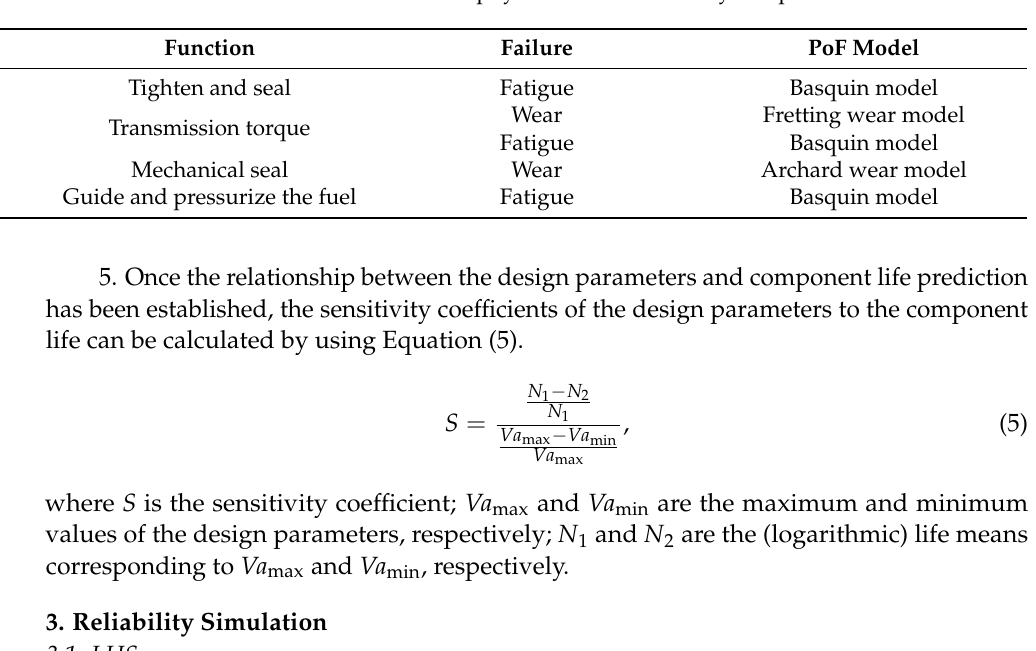
Table 1. The failure mechanism and failure physical model of the key